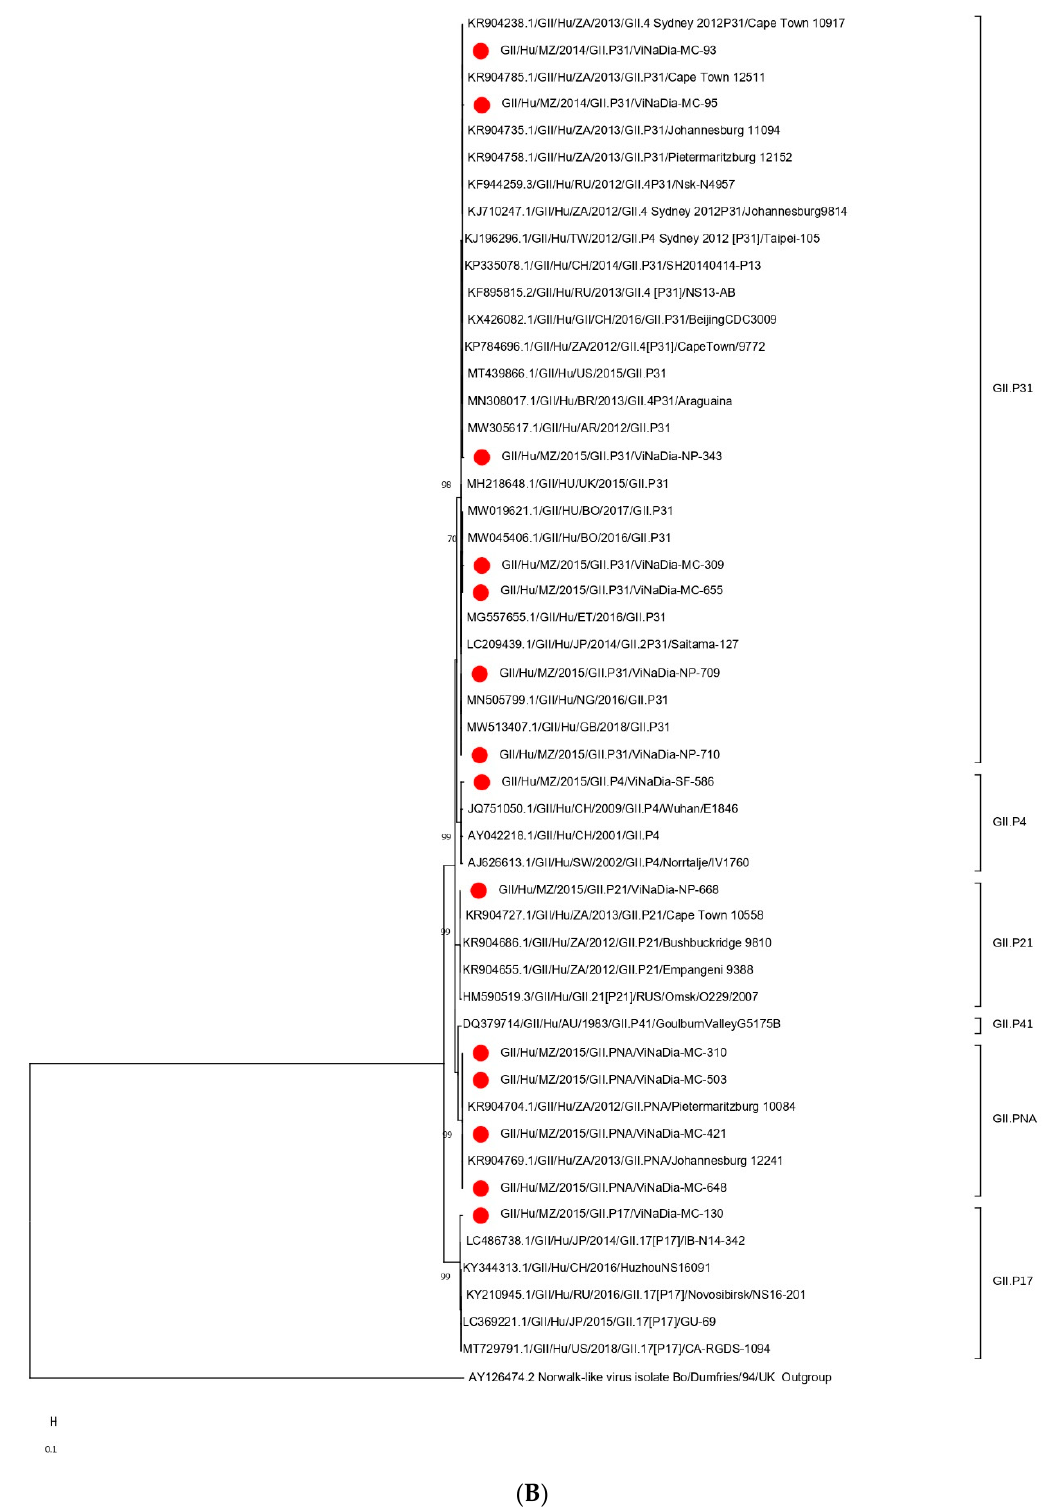
Figure 2. ( A ) Maximum-likelihood phylogenetic tree of partial VP1 gene (region C), representing 16 NoV GII strains comprising five genotypes from Mozambique, and ( B ) maximum-likelihood phylogenetic tree of partial RdRp gene (region A), representing 14 NoV strains depicting five P-types from Mozambique. Bootstrap support of >70% is indicated.